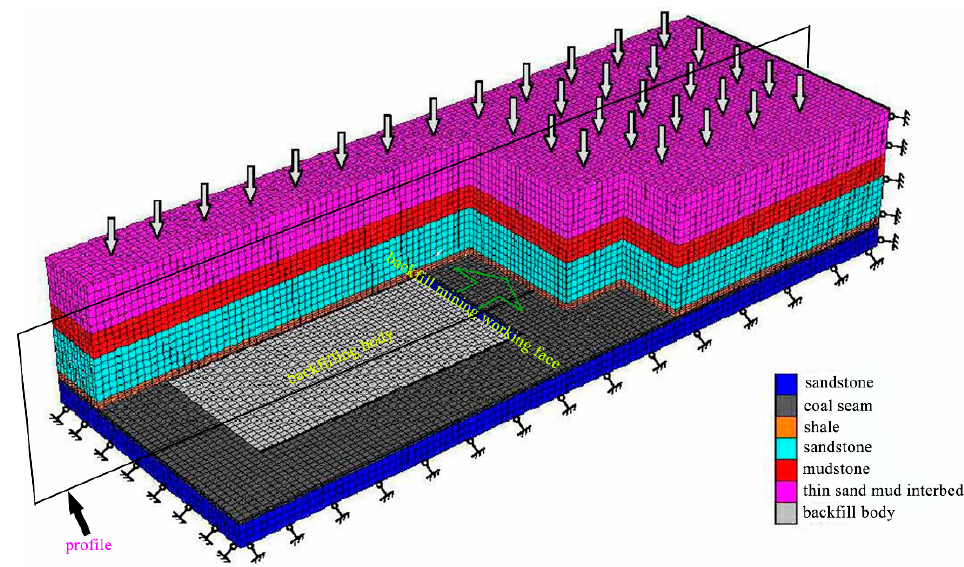
Figure 7. Numerical calculation model.